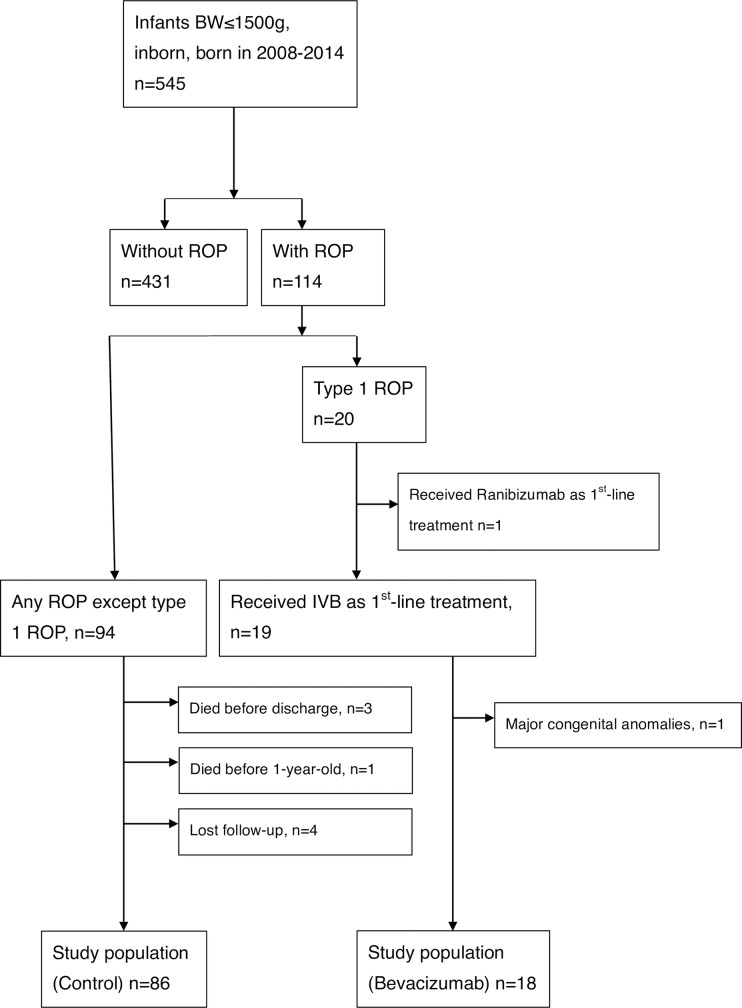
Patient enrollment algorithm.In total, 104 infants (bevacizumab, n = 18; control, n = 86) entered the final analysis conducted in this study.